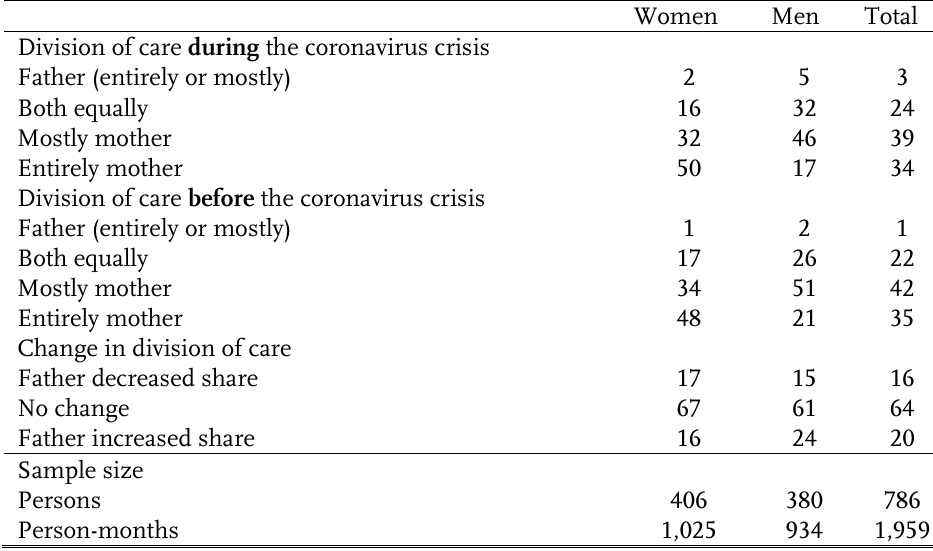
Table 2 : Division of child care, column per cent